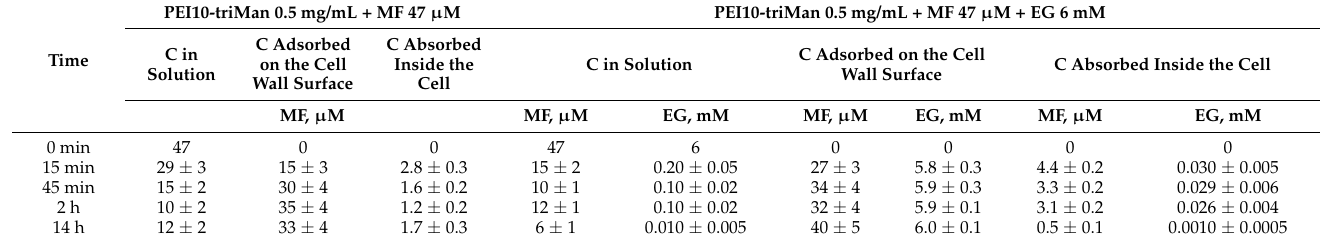
Table 5. Concentrations of MF and EG in solution adsorbed on the cell wall surface and absorbed by B. subtilis cells (10 6 CFU) depending on the composition of the system and incubation time. Incubation in medium LB (pH 7.2), 37 ◦ C. Fluorescent detection of MF and EG: λ exc = 280 nm, λ emi (EG) = 320 nm, ◦ λ emi (MF) = 465 nm–22